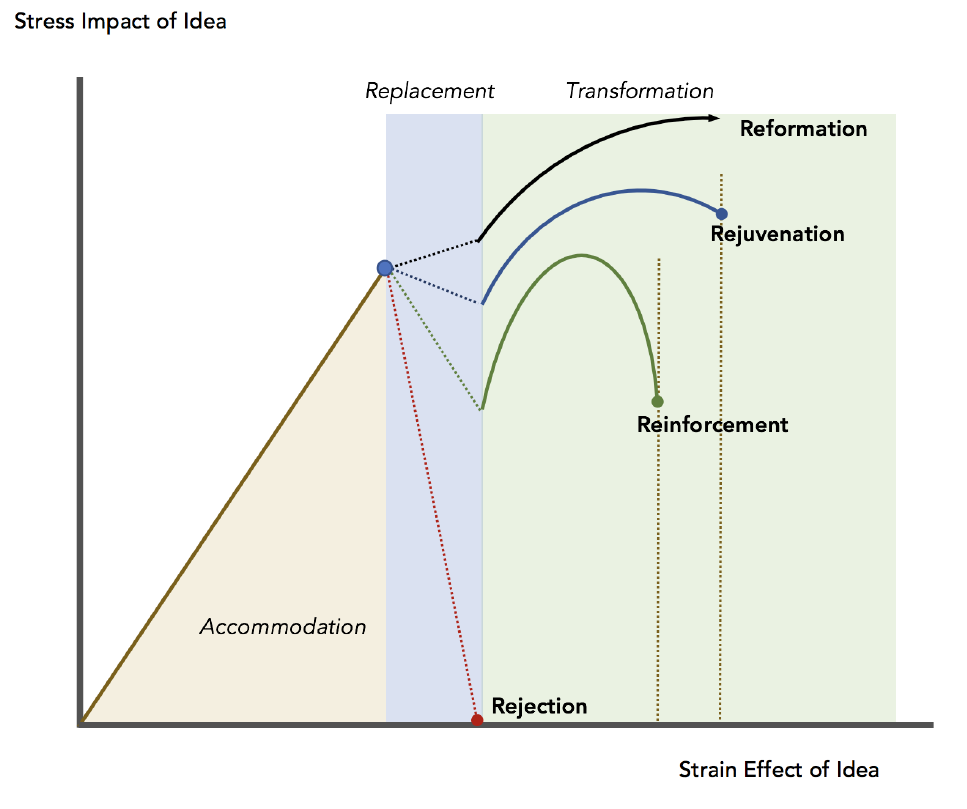
1. The first part of the curve shows a zone of accommodation , where the increase in an idea’s stress impact is absorbed by the system without causing any permanent fundamental change. Provided there is a cost for sustaining the idea’s stress on the system, when the idea is withdrawn the system returns to its original institutional parameters. Beyond the blue dot, the blue rectangle then represents a zone of replacement , where we can imagine a permanent slippage in the ideas inherent in the system; the incumbent ideas within the system are replaced by the stressing idea, and the original system’s configuration is now irrevocably lost. The extent of idea replacement determines the degree to which the new idea’s stress needs to be maintained in order to effect fundamental transformations to the subsequent configuration of the new and innovated system. In the zone of transformation , the idea’s stress impact creates fundamental transformations in a variety of ways ranging from a rejection of all old ideas to a reformation of them in conjunction with the new